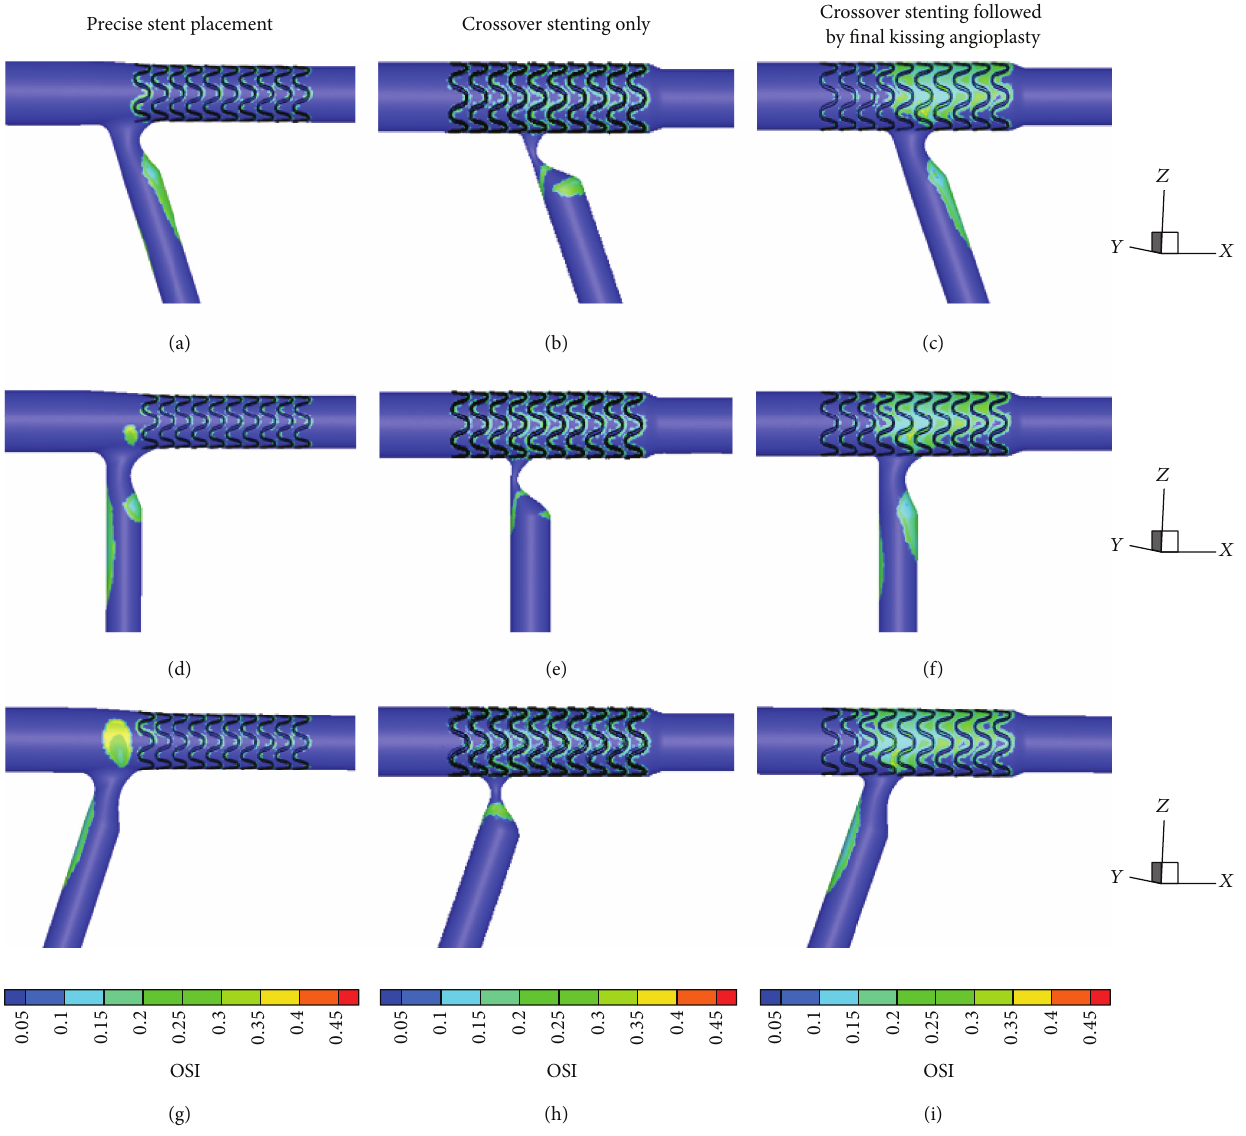
Figure 4: Oscillatory shear index (OSI) distribution at the bifurcation for the considered three stenting techniques under different bifurcation angle conditions. (a), (b), and (c) illustrate stenting techniques under 70 ∘ bifurcation angle condition; (d), (e), and (f) under 90 ∘ bifurcation angle condition; (g), (h), and (i) under 110 ∘ bifurcation angle